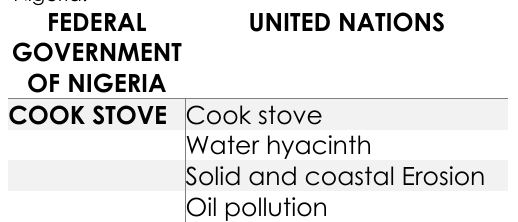
Table 3: Showing areas of non-intervention by FGN and United Nations on environmental issues as it concerns